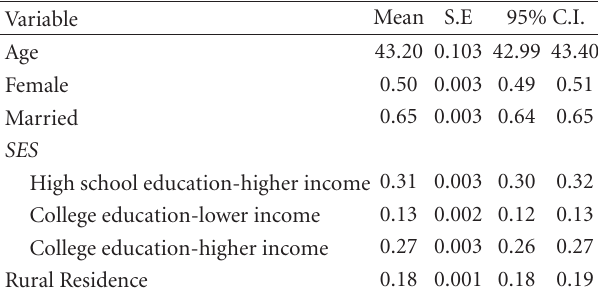
Table 1: Descriptive statistics ( n = 36,378,489;